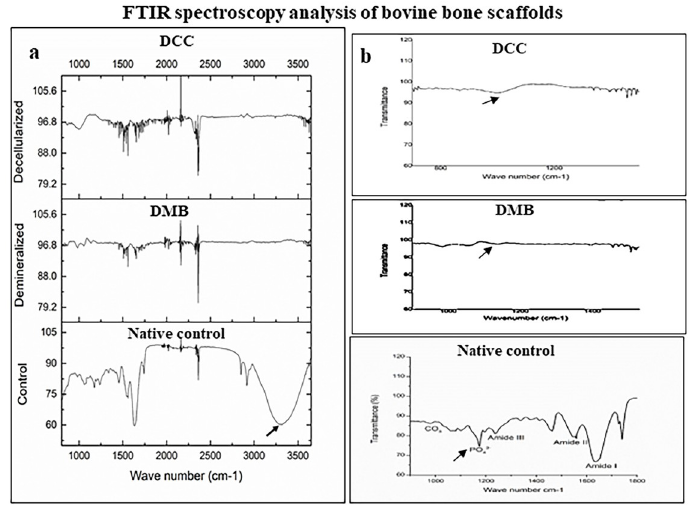
Fig 5. FTIR spectra of DMB and DCC scaffolds. A broad absorption peak of cholesterol is evident at 3412 cm − 1 in native control bone, whereas a similar peak is absent in DMB and DCC scaffolds (a). FTIR Spectrum of DMB and DCC bone scaffolds compared to native control bone. Regions of interest are indicated: carbonate (850–890 cm-1), phosphate (900–1200 cm-1), amide I (1585–1720 cm-1), amide II (1500–1600–1), and amide III (1250–1350 cm-1) absorption peaks (b); n = 4.